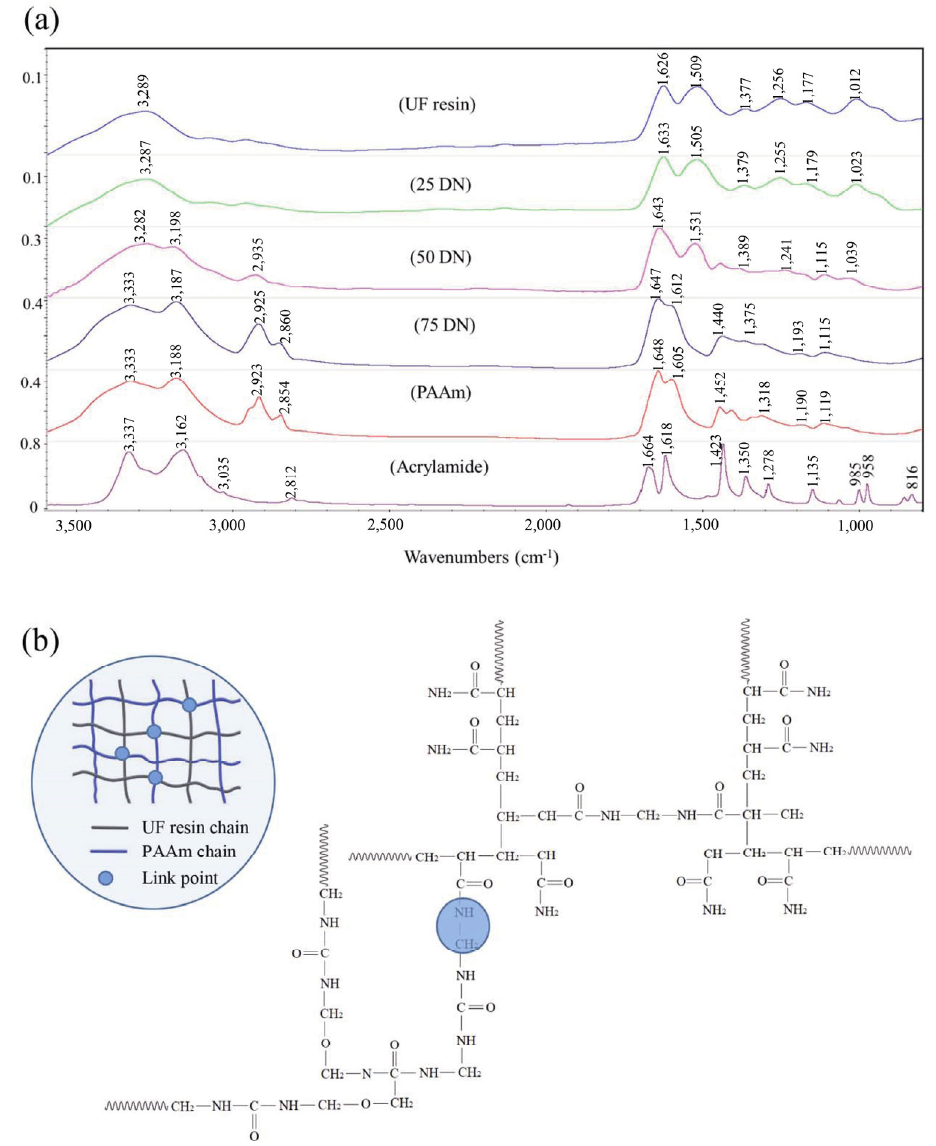
Fig. 3 Analysis and characterization of microspheres: (a) infrared spectrum diagram of acrylamide monomer and different microspheres, (b) chemical structure of DN